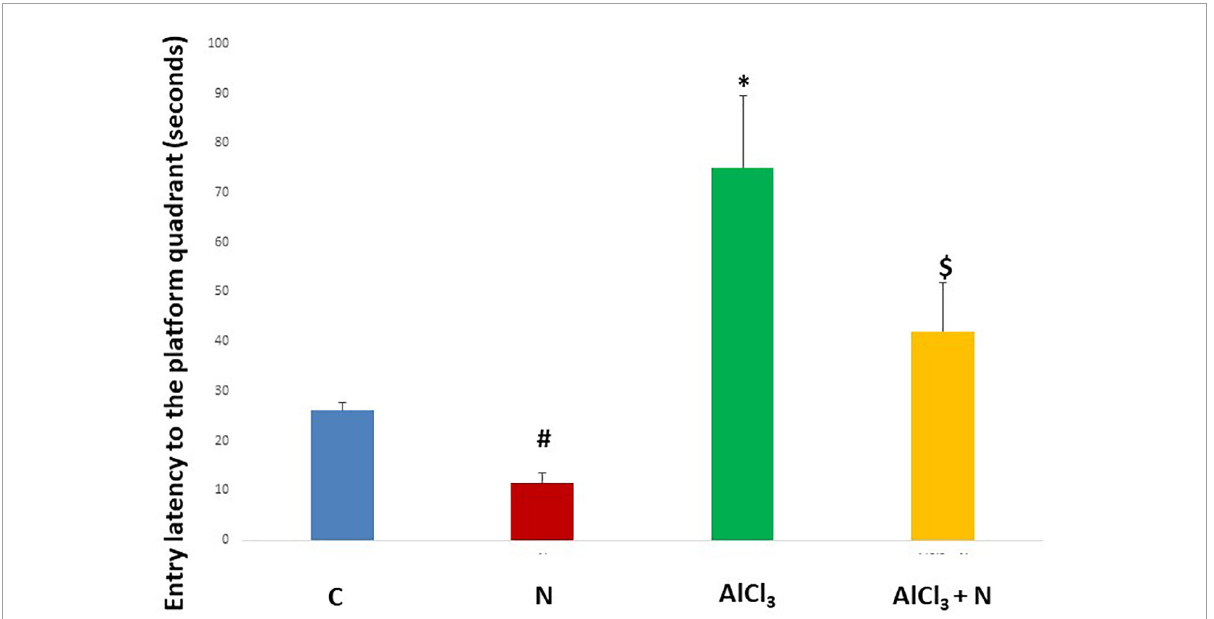
FIGURE4 Entry latency in the Morris water maze test in the studied groups. n = 6 in each group. Data were prescribed as mean ± SD . The intergroup variation was conducted by Games-Howell post-hoc test. ∗ p < 0.001 compared with C group. # p < 0.001 compared with AlCl 3 . $ p < 0.001 compared with AlCl 3 .